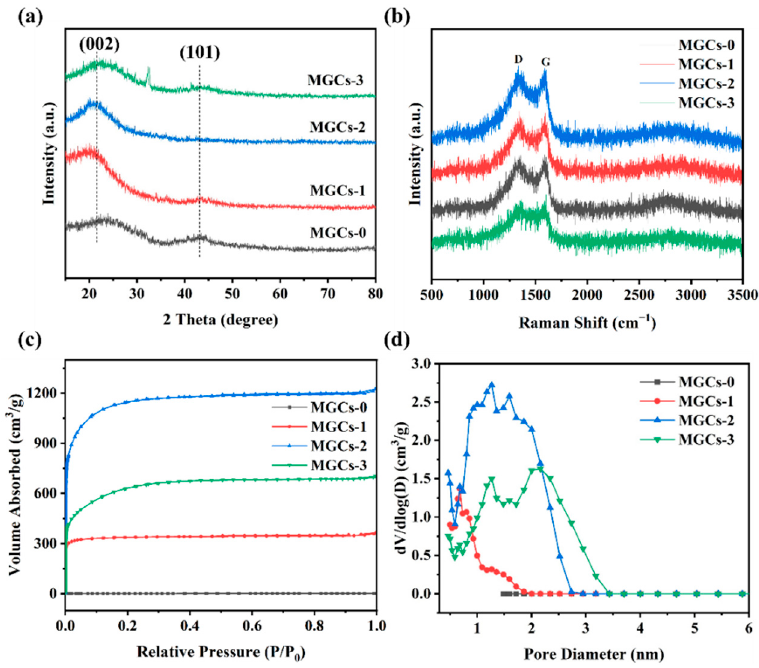
Figure 3. ( a ) XRD patterns; ( b ) Raman spectra; ( c ) nitrogen adsorption − desorption isotherms; ( d ) corresponding pore size distribution of MGCs.